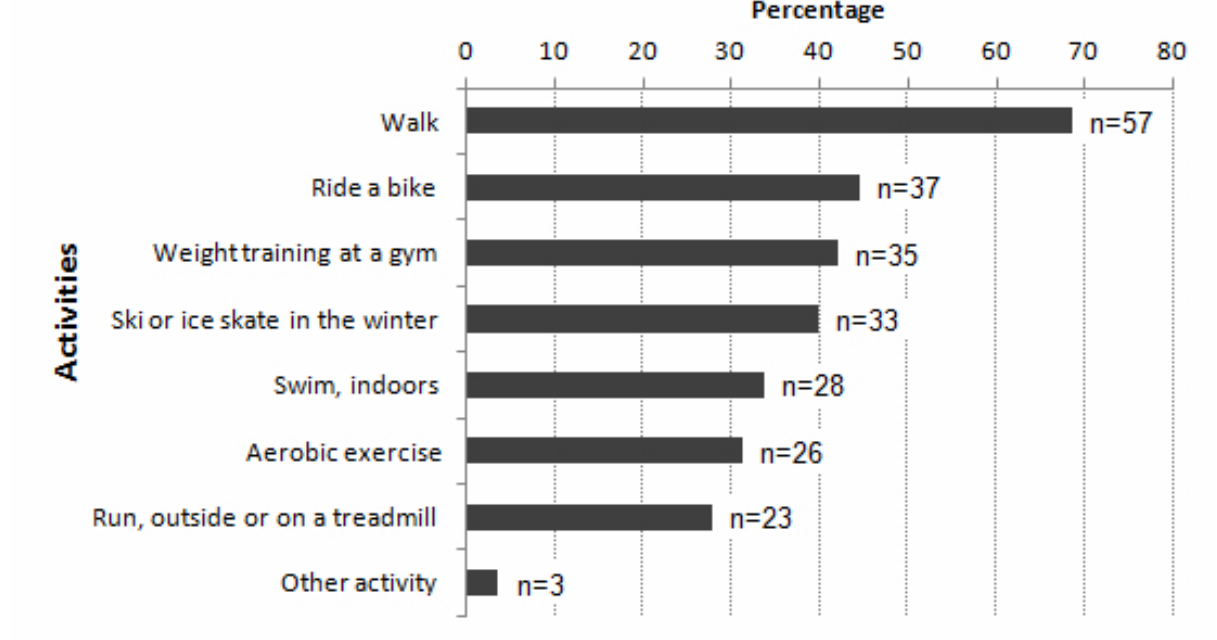
Figure 4. Preferred activities among men that would like to be more physically active